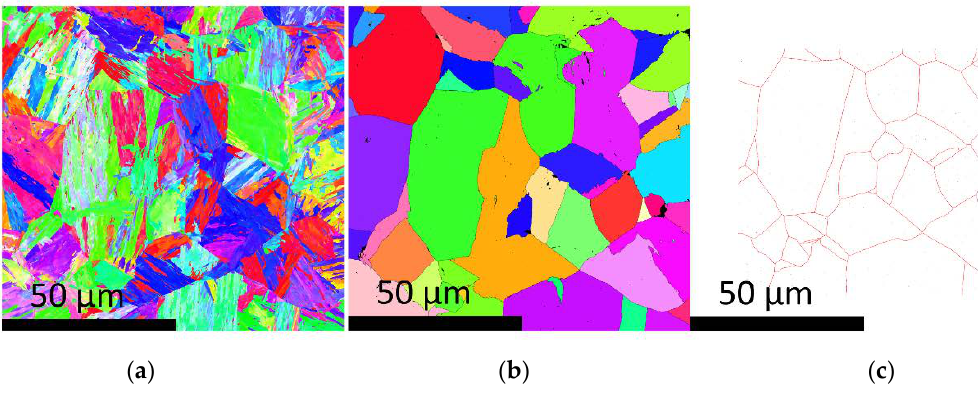
Figure 1. Maps for the steps of the PAG (prior austenite grain) boundary segmentation: ( a ) EBSD map of the martensitic microstructure; ( b ) reconstructed map of the prior austenitic grain structure; ( c ) segmented PAG boundaries.